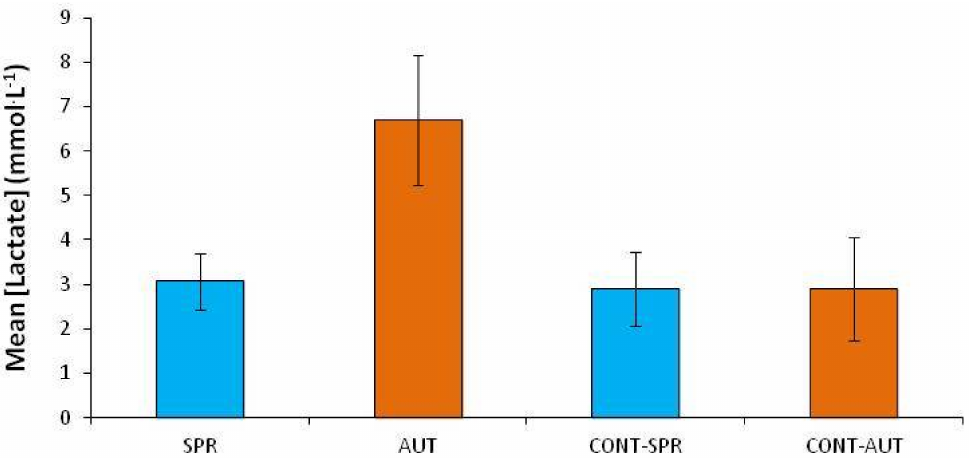
Figure 4. Mean lactate concentration ± SD (mmol · L − 1 ) measured in the I. barbel in both seasons (spring-SPR and autumn-AUT) and in control fish, spring (CONT-SPR) and autumn (CONT-AUT). Significant differences were found between lactate concentrations of tested fish in autumn (AUT) and control fish in autumn (CONT-AUT) ( p <